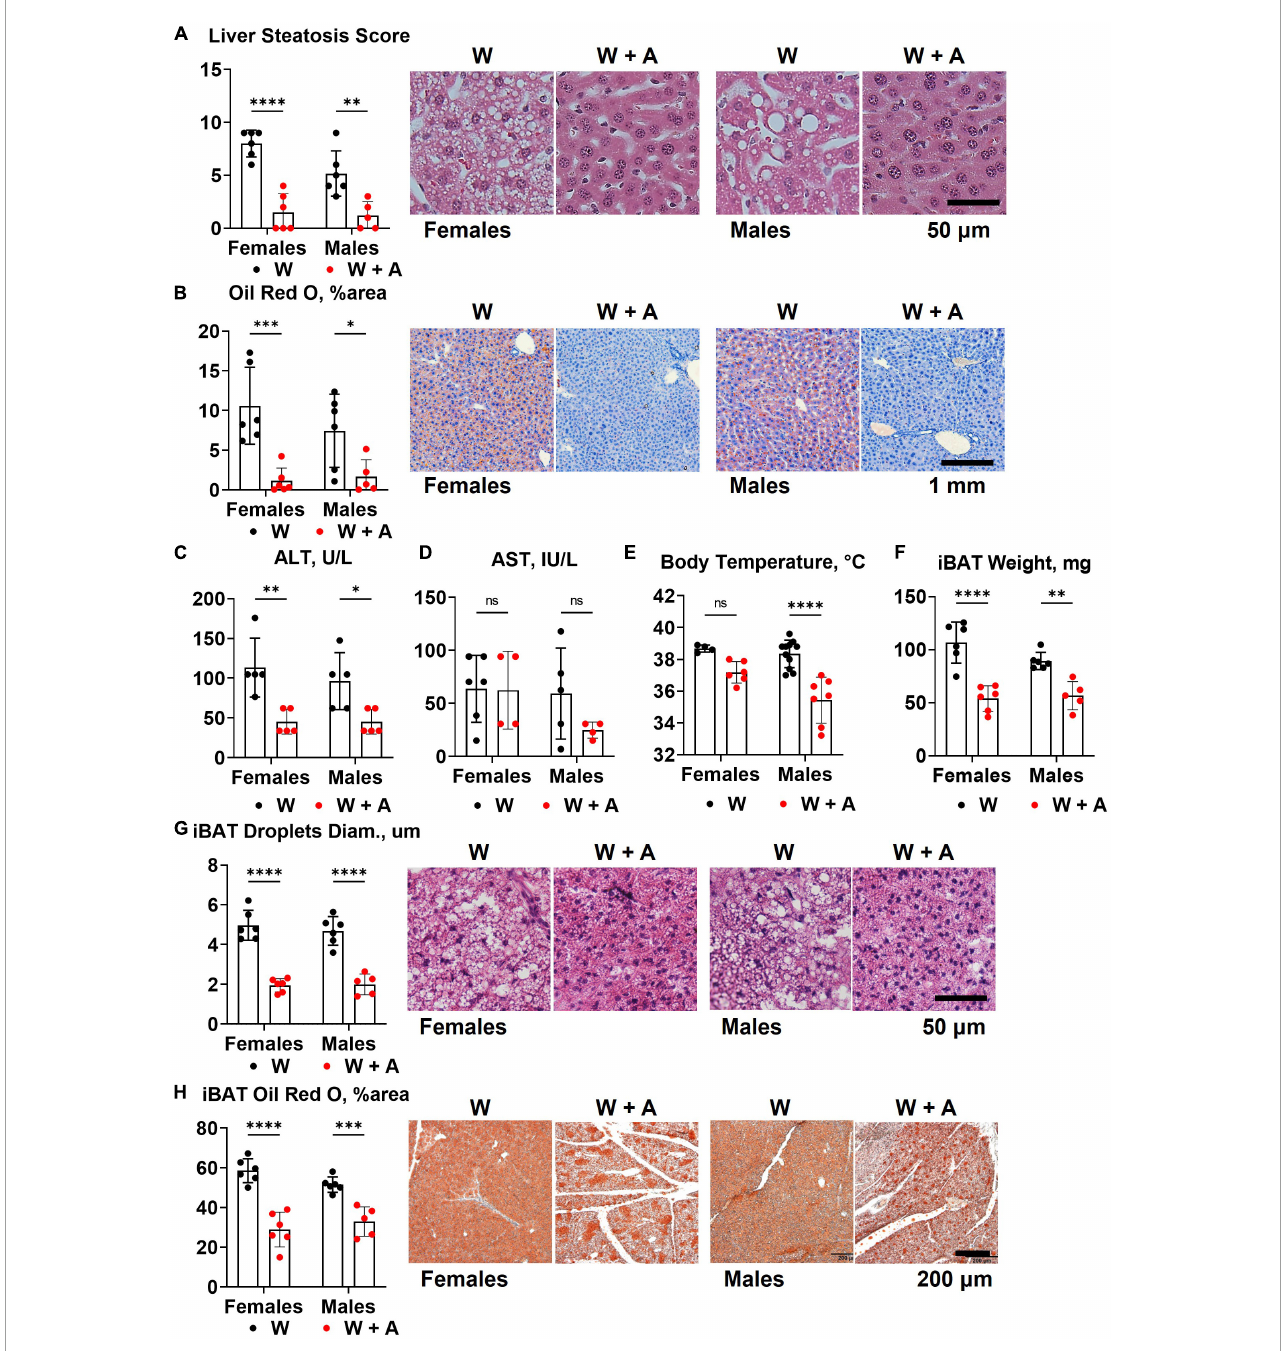
FIGURE4 Liver and brown adipose tissue phenotypes of WHC mice treated with a western diet with or without adenine. (A) Pathology scores and representative images of H&E staining of the liver. (B) Representative images and quantification of Oil red O staining of the liver. (C) Plasma alanine transaminase (ALT). (D) Plasma aspartate transaminase (AST). (E) Core body temperature. (F) Interscapular brown adipose tissue (iBAT) weight. (G) Average diameter of lipid droplets in iBAT and representative images of iBAT stained with H&E. (H) iBAT lipis content detected by Oil red O staining. n = 4–11 per group; two-way ANOVA; ns, not significant; ∗ p < 0.05; ∗∗ p < 0.01; ∗∗∗ p < 0.001; ∗∗∗∗ p < 0.0001.